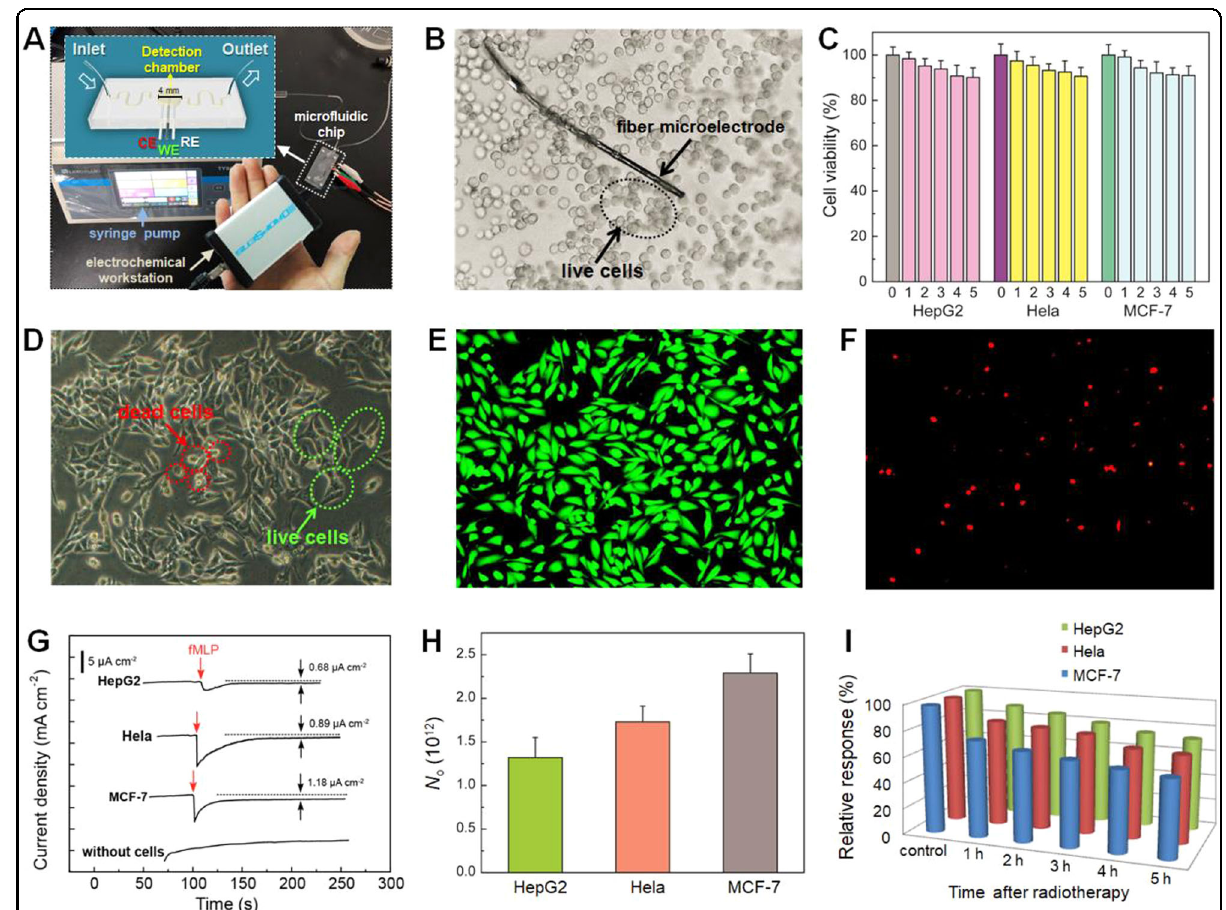
Fig. 4 Real-time tracking of cancer cells by an electrochemical micro fl uidic biosensor based on NBP-CNW-NTAs/CF. A Digital photo of the homemade micro fl uidic electrochemical sensing system. B Superresolution digital microscope images of MCF-7 cells incubated with NBP-CNW- NTAs/CF in the chip. C Quantitative cell viability results of CCK-8 assay for different cancer cells incubated with the NBP-CNW-NTAs/CF microelectrode from 0 h to 5 h. D – F Bright- fi eld and dark- fi eld fl uorescent images of MCF-7 cells after the calcein-AM/PI assay to stain the viable cells green by calcein-AM and dead cells red by PI. G Amperometric current responses of the electrochemical sensor to the addition of 0.1 mM fMLP into the test solutions with HepG2, HeLa and MCF-7 cells and without cells. H Histograms of the N o values for HepG2, HeLa and MCF-7 cells. I Histograms of the N o values for MCF-7 cells after 0 h (control), 1, 2, 3, 4 and 5 h of radiotherapy and without any